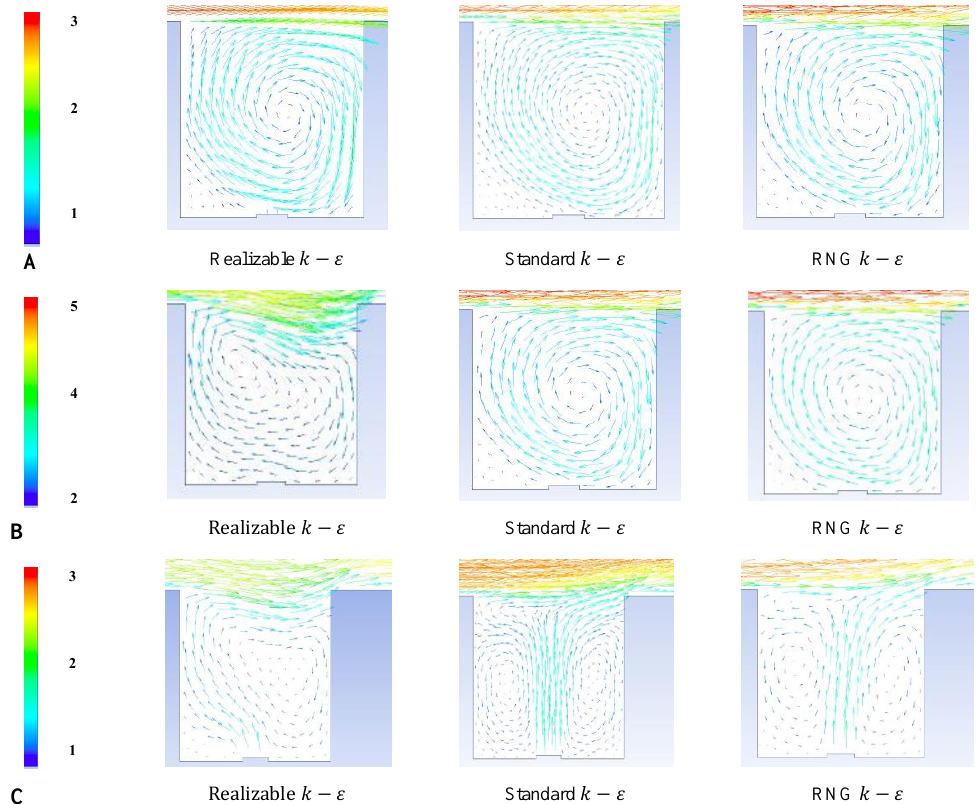
Fig. 3. Wind-speed distribution within a street canyon (AR=1) under different turbulence models. (A: Qe = 4 l/h and Uw=2 m/s; B: Qe = 4 l/h and Uw=4 m/s; C: Qe = 40 l/h and Uw=2